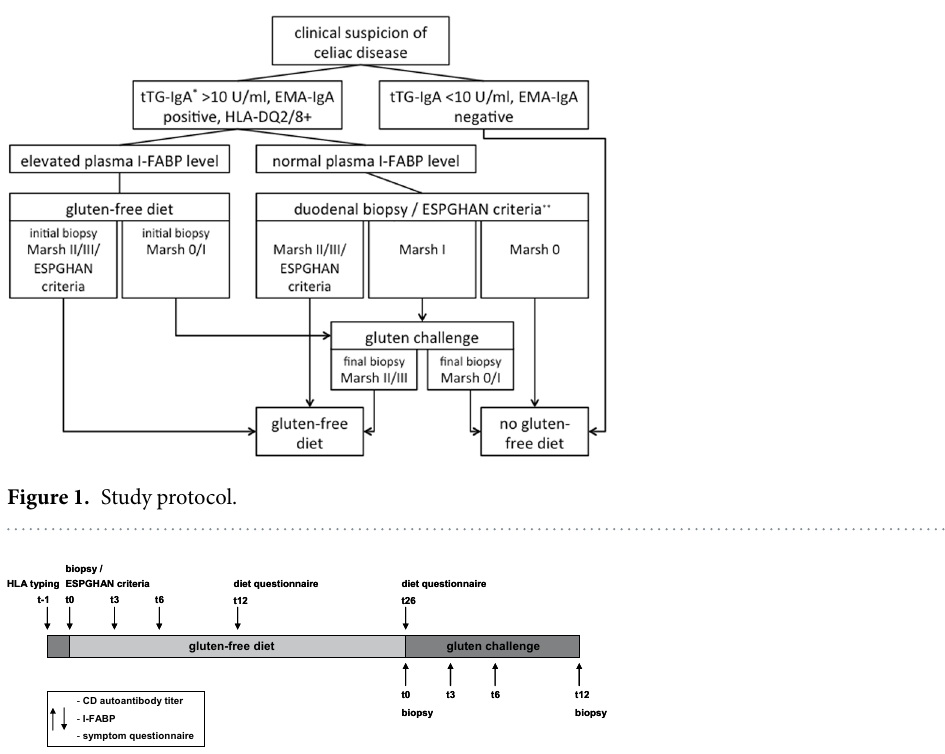
Figure 2. Study visits and measurements at disease presentation and during follow-up of all included